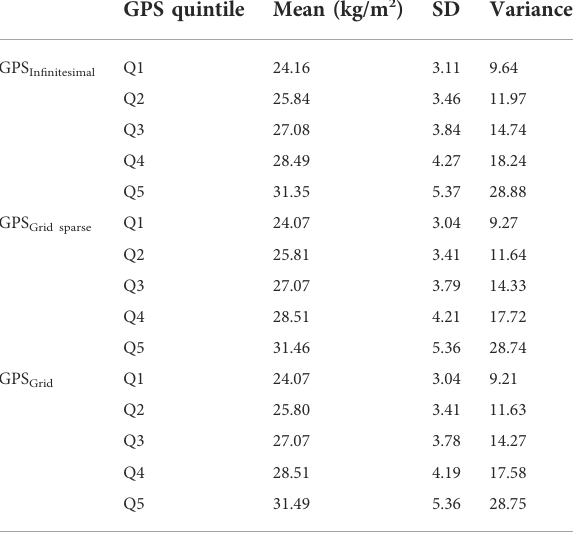
TABLE 2 The mean, SD, and variance of BMI for each GPS quintile group.